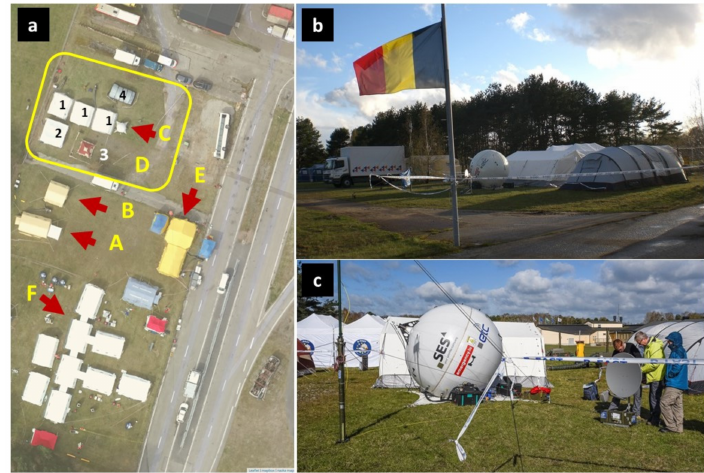
Figure 5. B-LiFE/B-FAST deployment during the MODEX international exercise in Sweden, 20–24 April 2017. ( a ) Aerial view by drone: arrows indicated the laboratory tent with the sample reception area ( A ), the SatCom command and control post ( B ), the GATR antenna for SatCom ( C ). The yellow square ( D ) shows the B-FAST (Belgian first aid and support team) logistic complex with the tent set-up comprising a dormitory ( 1 ), a dining area ( 2 ), an infirmary ( 3 ), and a global command and control tent ( 4 ). Arrows E and F indicate the Italian Field Hospital ( E ) and the EUCPT tent ( F ). ( b ) Global view of the B-LiFE/B-FAST deployment site. ( c ) Inflatable GATR and dish antenna for satellite